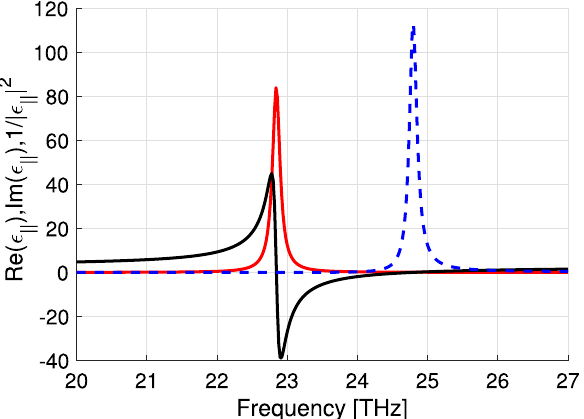
2 ǫ (blue dashed | � |